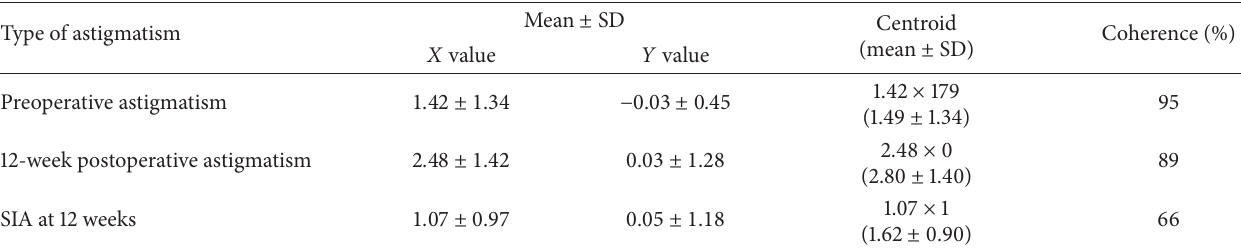
Table 2: Results of the Cartesian coordinates based